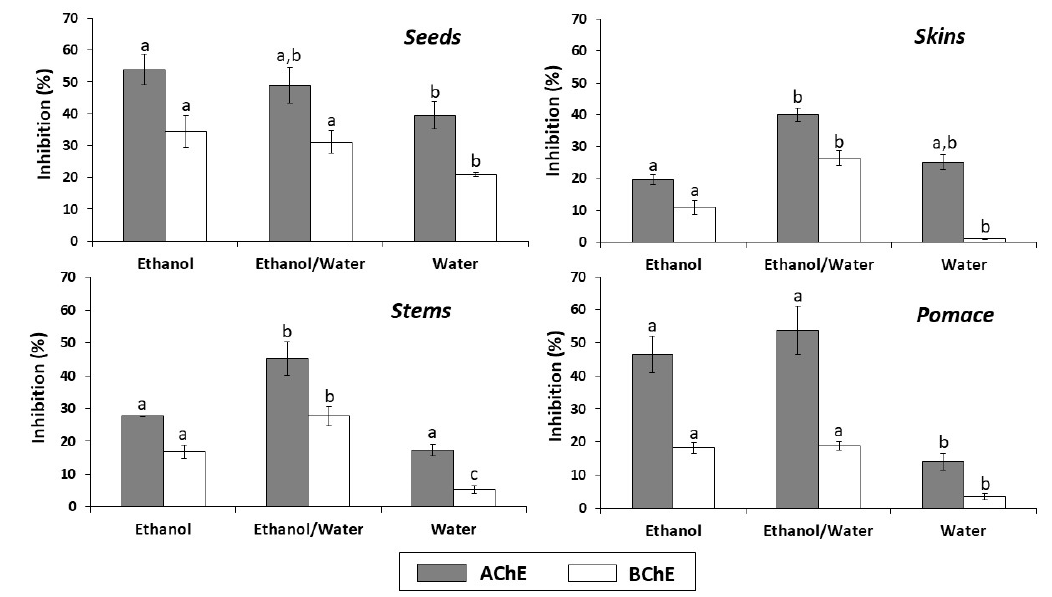
Figure 3. In vitro cholinesterase inhibitory activity of seeds, skins, stems and pomace extracts (2.5 mg/mL) obtained with different solvents. In each graph, for acetylcholinesterase (AChE) or butyrylcholinesterase (BChE), the letters indicate significant differences ( p < 0.05) between ethanol, ethanol/water and water extracts by Tukey's test.